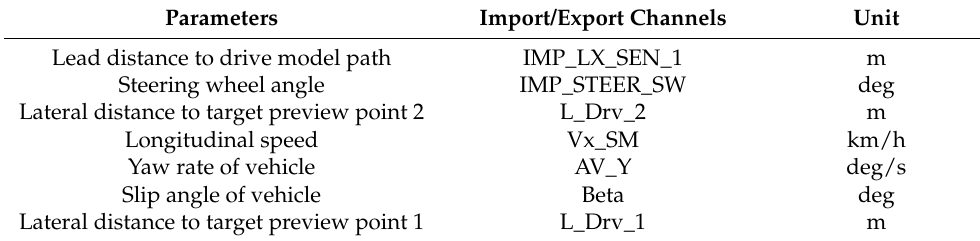
Table 2. Carsim import/export channels.